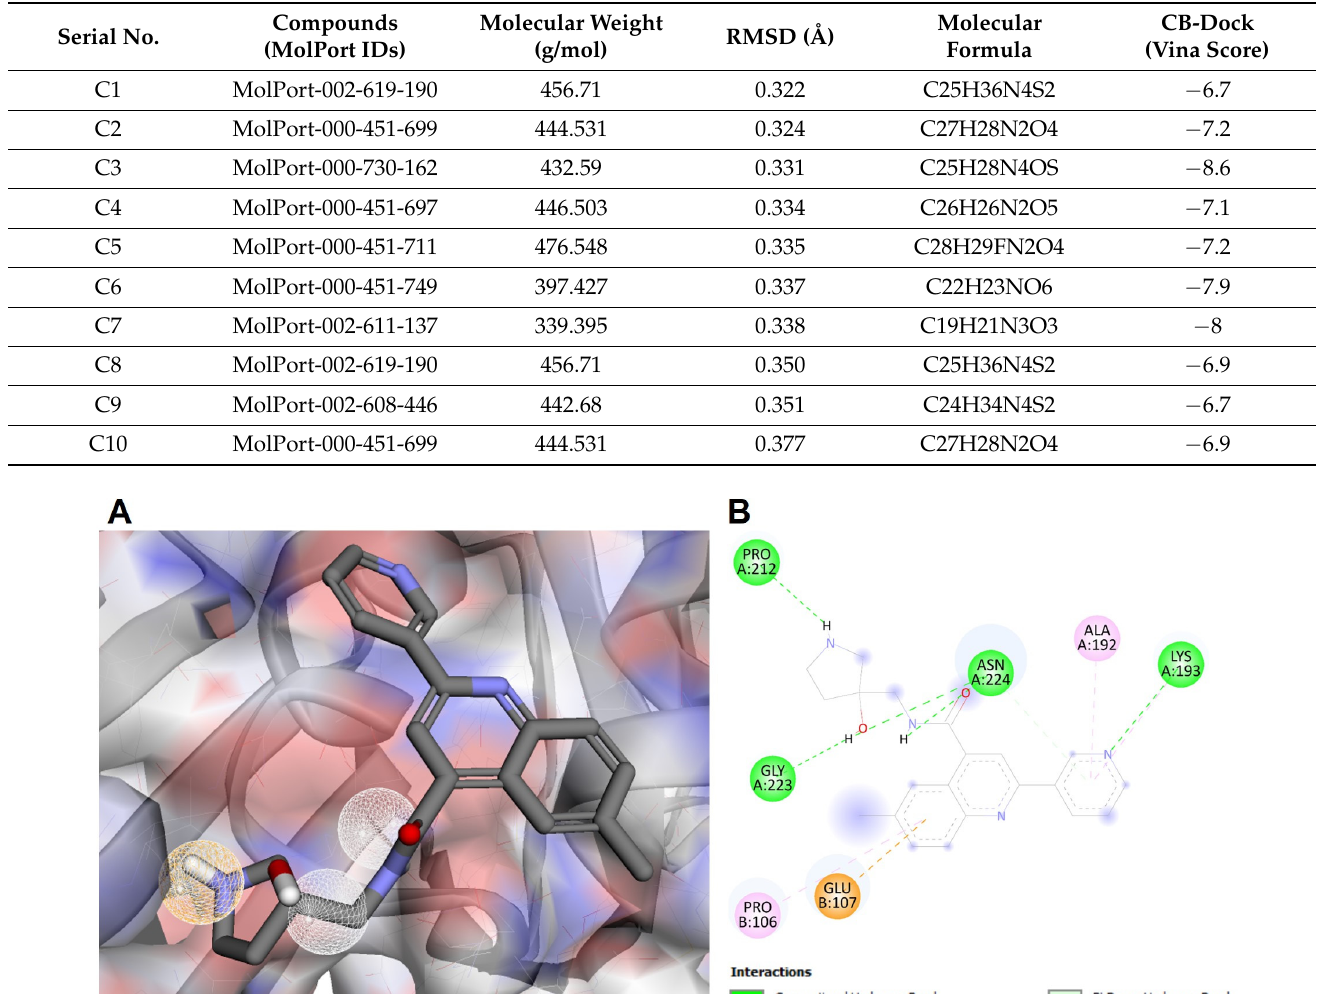
Table 2. CB-Dock scores and RMSD values of top 10 hit molecules obtained against UGPase target from virtual screening using Pharmit server.